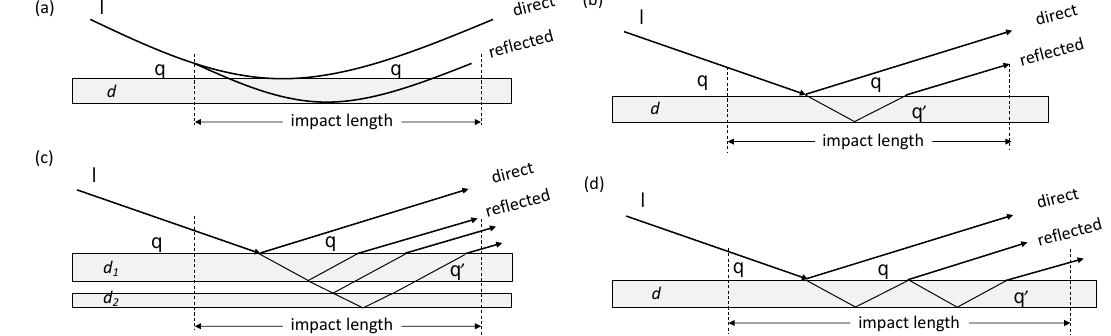
Figure A6. ( a ) RO limb sounding rays in a flat surface projection; ( b ) RO direct and single-layer reflected paths in a thin film model; ( c ) RO direct and double-layer reflected paths in a thin film model; and ( d ) RO ducting in a thin film model. The impact length is the region where RO experiences a significant bending as defined in Figure 1, and the elevation angle ( q ) increases as H SL decreases.